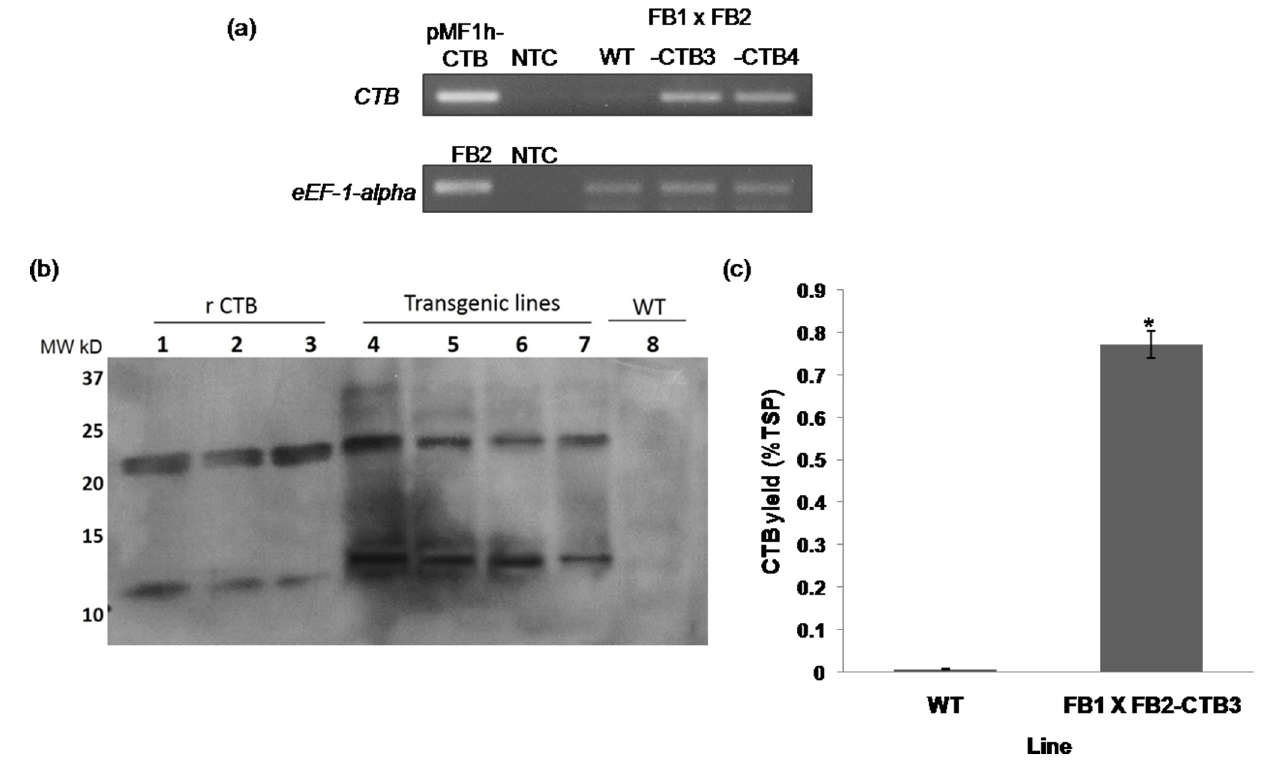
Fig 4. V . Cholerae CTB gene is successfully expressed in corn smut galls ( ‘ huitlacoche ’ ). Corn cobs were inoculated with the crosses FB1 x FB2-CTB 3 and FB1 x FB2-CTB 4, and FB1 x FB2 as control. (a) Expression analysis of the CTB gen in ‘ huitlacoche ’ by semi-quantitative RT-PCR. Total RNA was isolated from fresh WT or transgenic corn smut galls (teliospores). Genomic DNA from U . maydis FB2 strain, the plasmid pMF1h-CTB, and a sample without template (NTC), were used as control. (b) Detection of the CTB protein in corn smut galls protein extracts by Western Blot analysis. Protein extracts were subjected to SDS PAGE under reducing conditions, blotted, and then labelled with an anti-CTB serum. Lanes 1 to 3, pure CTB standard (500, 250, and 100 ng, respectively); 4 and 5, extracts from ‘ huitlacoche ’ produced with the FB1 x FB2-CTB3 cross; 6 and 7, ‘ huitlacoche ’ produced with the FB1 x FB2-CTB 4 cross; and 8, extract from WT ‘ huitlacoche ’ (FB1 x FB2). (c) Quantification of CTB levels in terms of %TSP by GM1-ELISA assay. Oligomeric CTB was detected in total soluble protein extracts from either FB1 x FB2-CTB 3 galls or WT galls followed by immunodetection with an anti-CTB serum. The Asterisk denotes statistical differences at P < 0.05 versus WT galls.